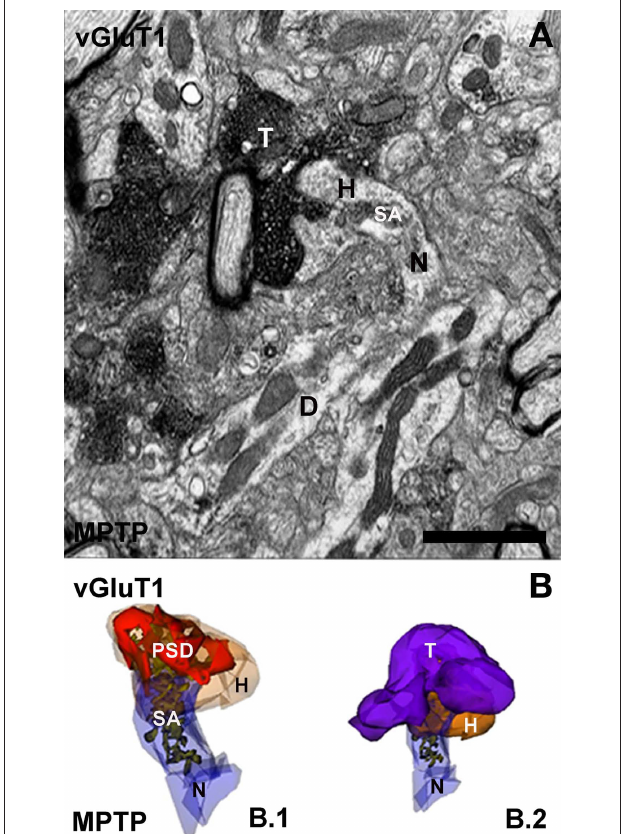
Figure 3 | electron micrograph and three-dimensional (3D) reconstruction of a corticostriatal (vgluT1-immunoreactive) axo-spinous synapse in the striatum of a MPTP-treated monkey. (A) Electron micrograph of a synapse between the spine of a MSN and a vGluT1-positive terminal (T). (B) 3D-reconstructed images from serial electron micrographs of the head (H) and neck (N) of the spine (B.1) and the axo-spine synapse (B.2) shown in (A) . In (B.1), the spine is partially transparent to illustrate the complexity and distribution of the spine apparatus (SA) and the postsynaptic density (PSD). D, dendrite. Scale bar in (A) : 1